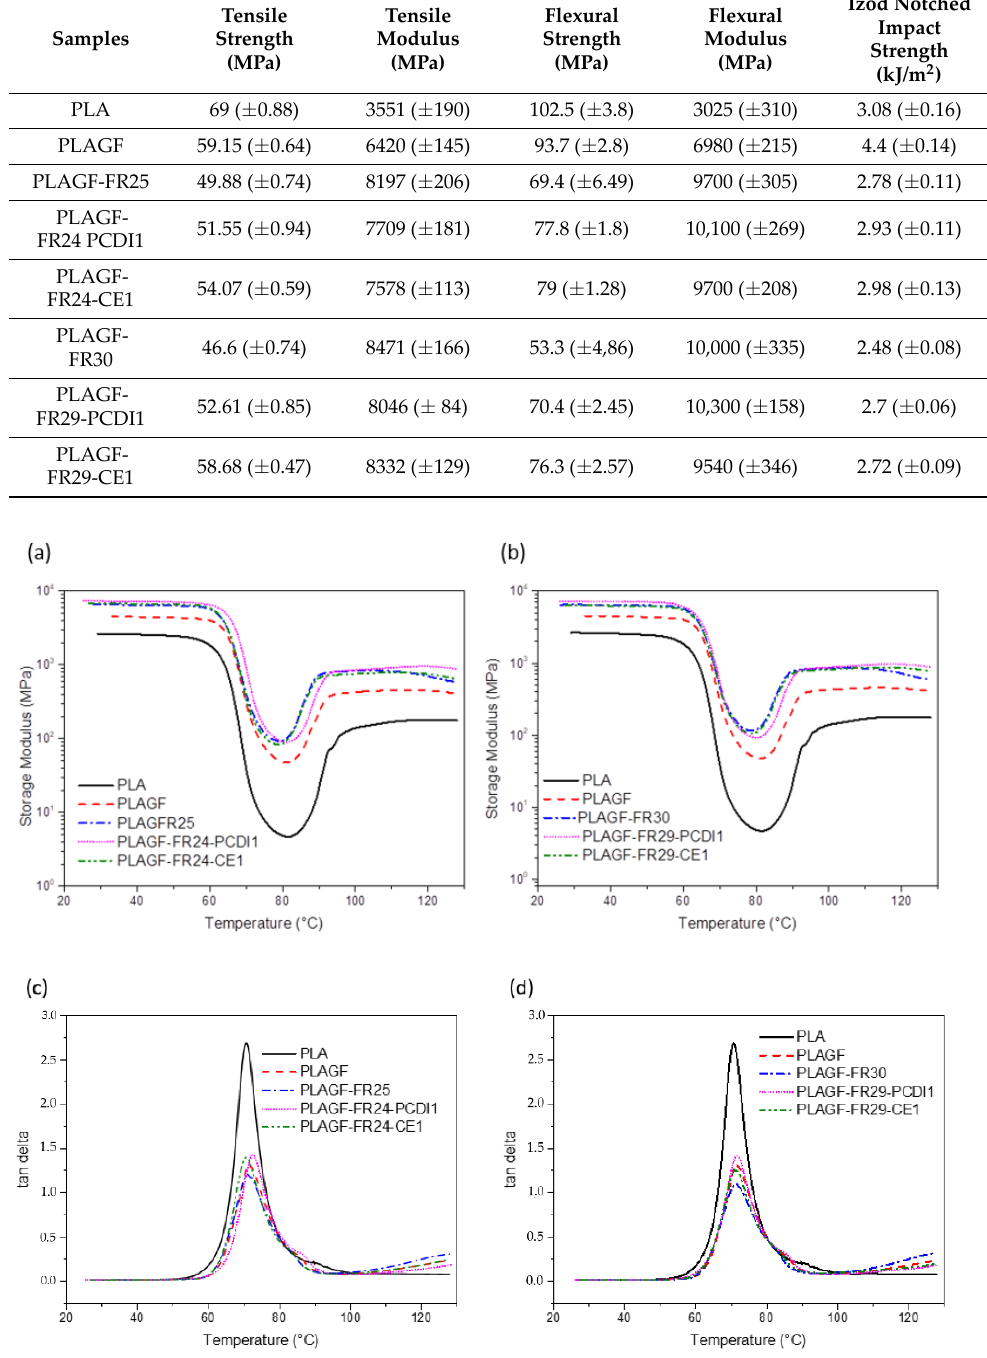
Figure 7. Storage modulus comparison of PLA composites with ( a ) 25 wt% and ( b ) 30 wt% FR; and tan δ graphs with ( c ) 25 wt% and ( d ) 30 wt% FR.